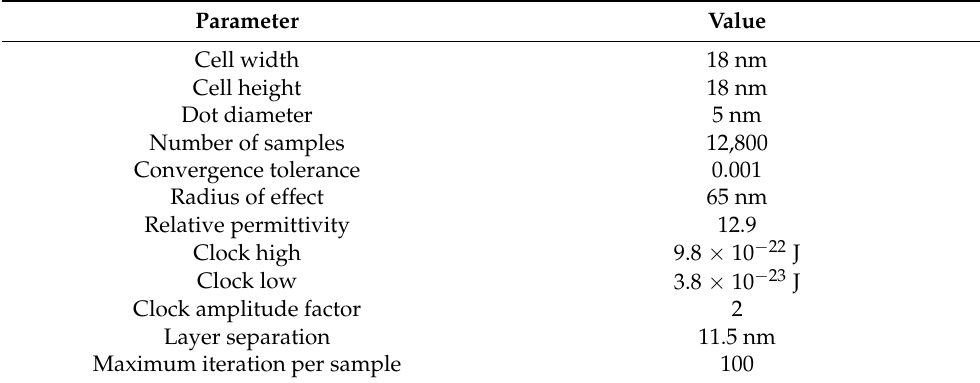
Table 2. Simulation parameters for the QCA Designer.